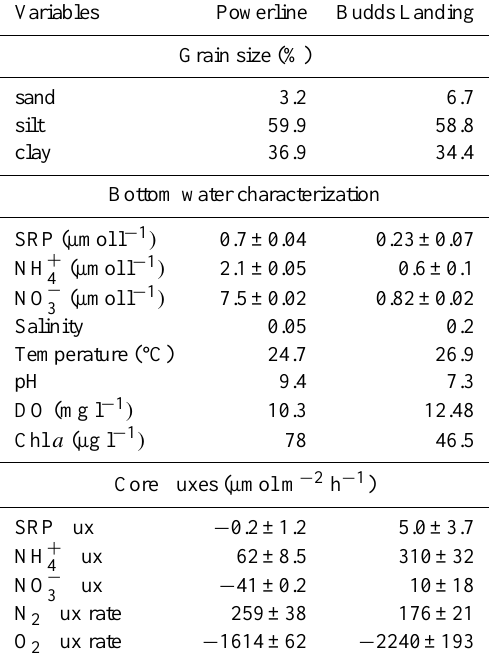
Table 1. Sediment grain size, ambient dissolved nutrients in water column and the flux rates before pH modification. Samples were collected at the Powerline site on 18 June 2008 and Budds Land- ing site on 14 July 2009. Grain size measurements were made after flux experiments; other measurements for dissolved nutrient con- centrations (average±SE, n = 3) in the bottom water and flux rates (mean±SE, n = 4–9) were carried out before pH treatments. Neg- ative flux rates indicate uptake by the sediment.